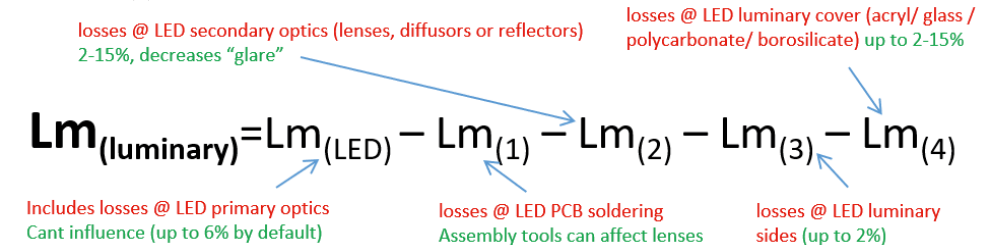
Figure 1. Typical places of total luminary lumen losses in LED luminary manufacturing process